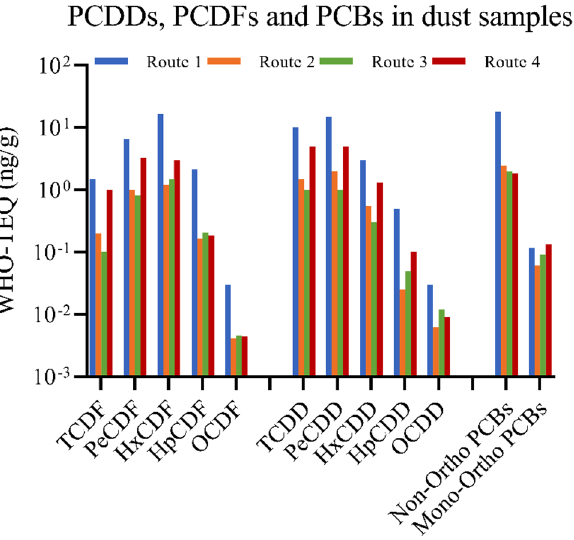
Figure 3. Concentrations of PCDDs, PCDFs and PCBs (WHO-THQ ng/g) in exhausted dust samples.